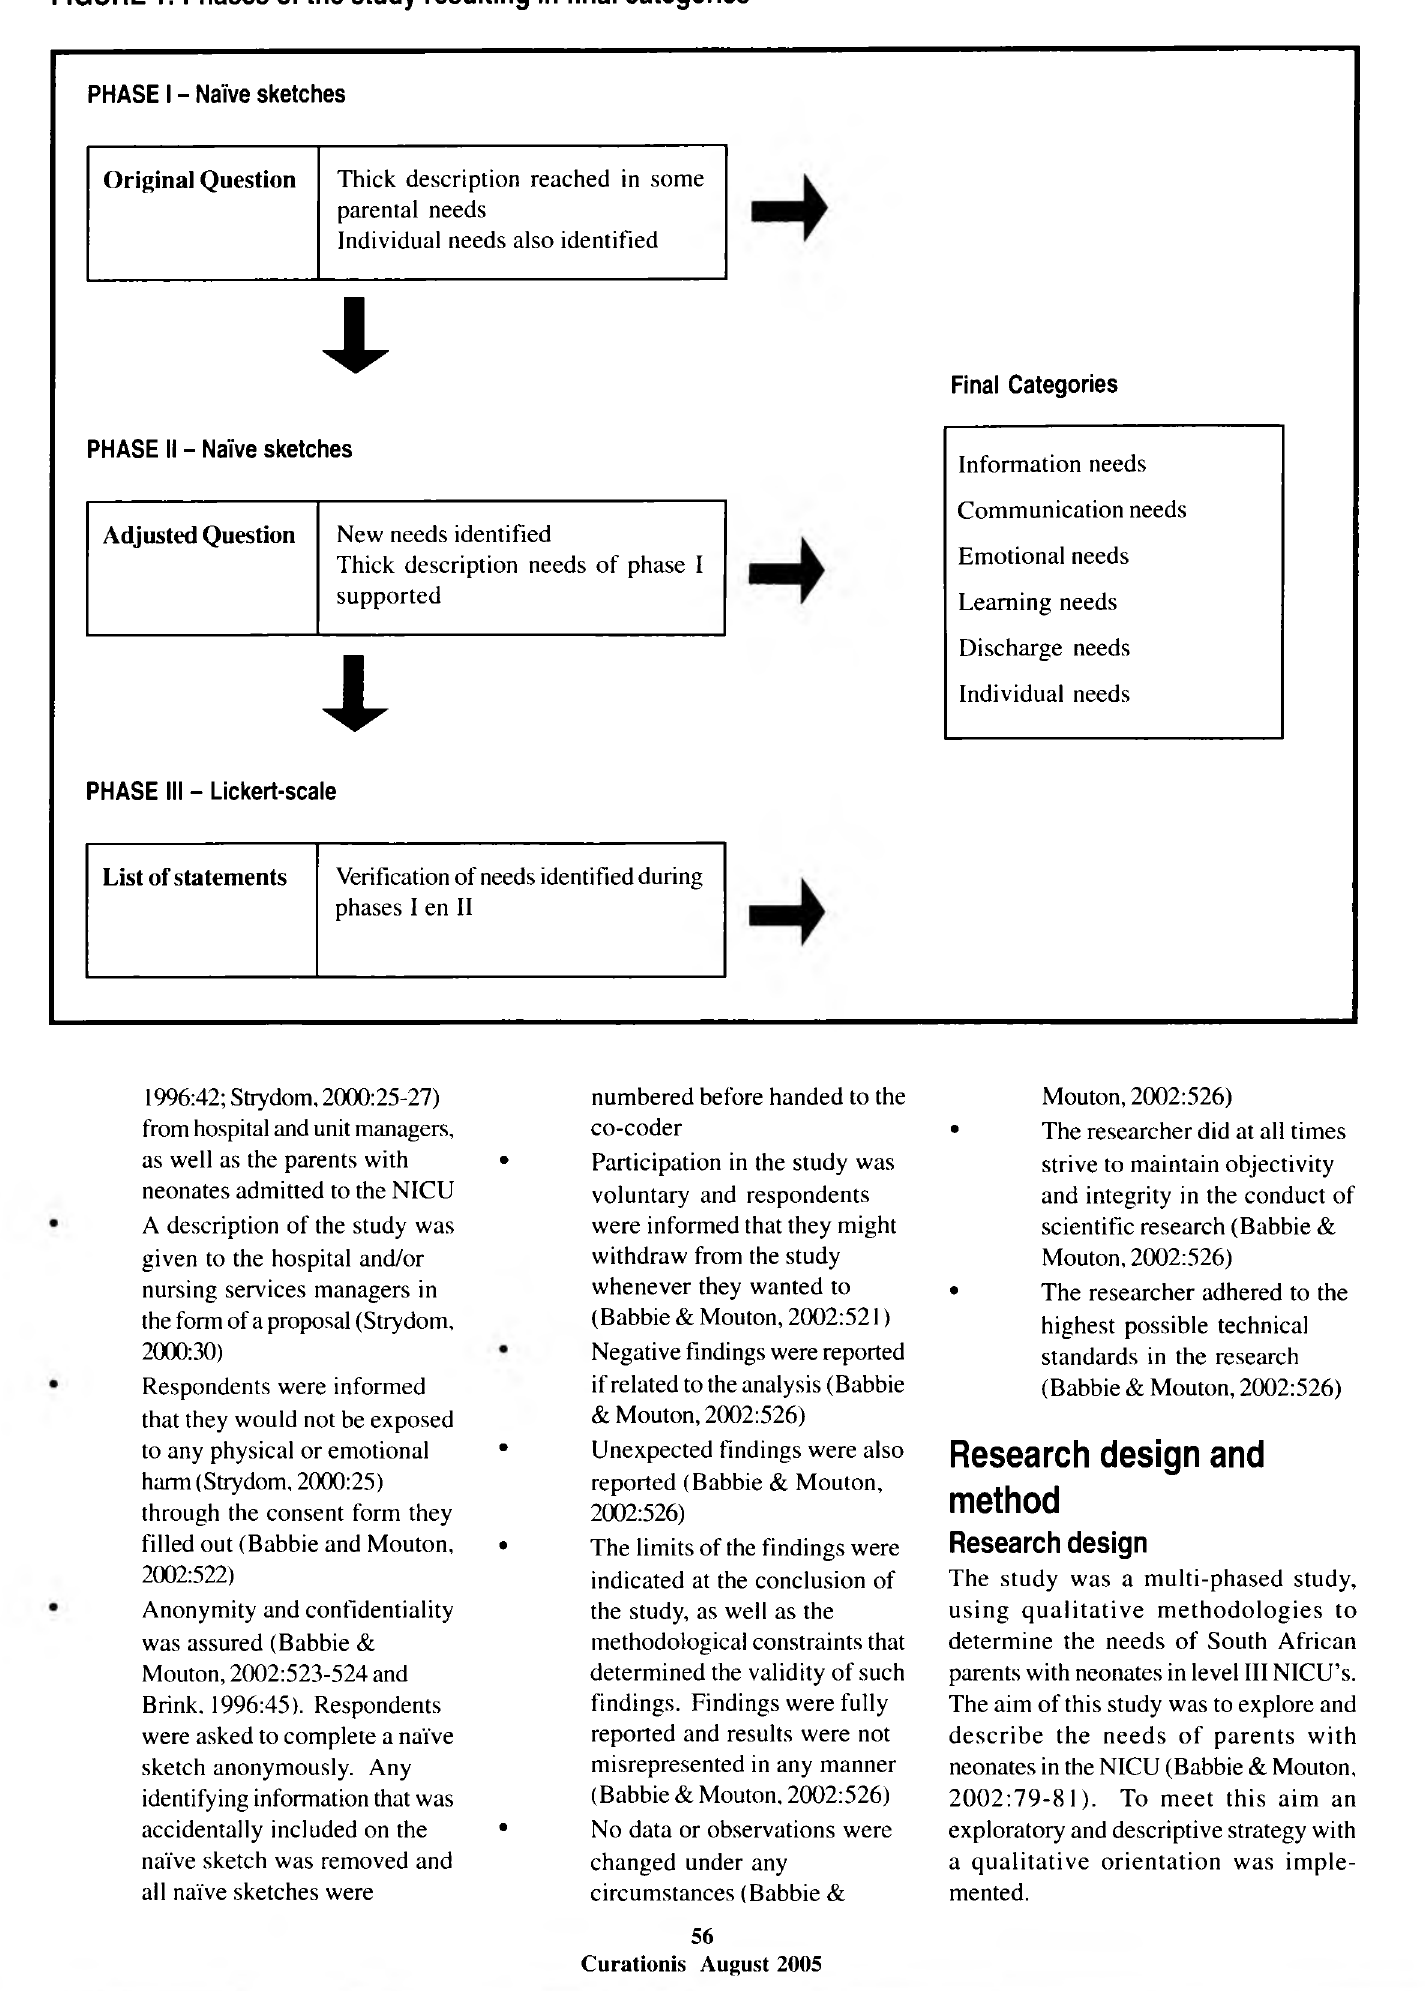
FIGURE 1: Phases of the study resulting in final categories